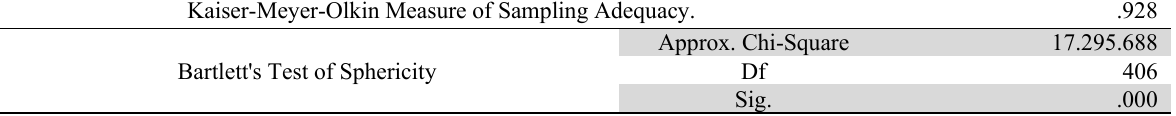
KMO and Bartlett's Test Kaiser-Meyer-Olkin Measure of Sampling Adequacy.